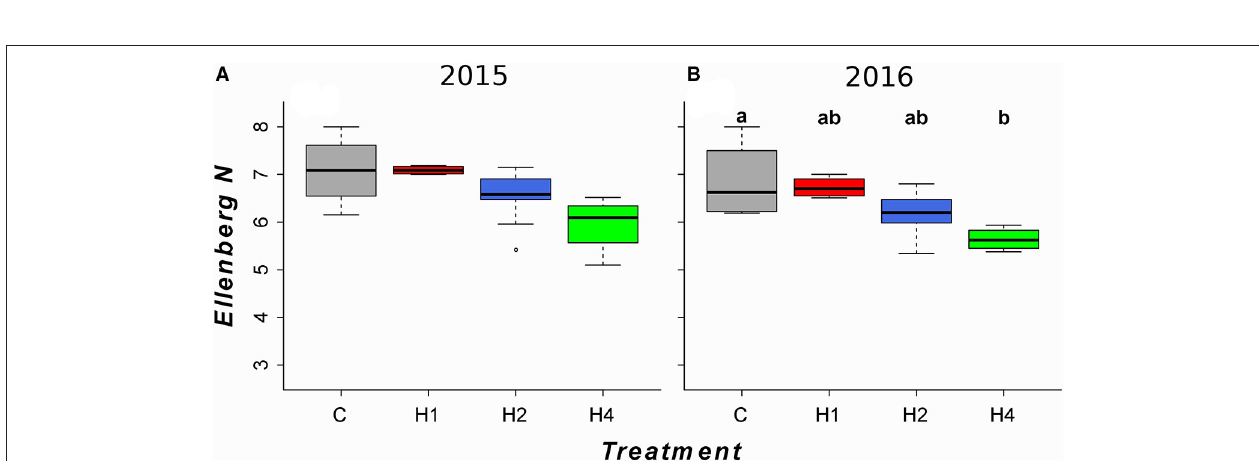
FIGURE 5 | Boxplots of community-weighted preference for soil fertility (Ellenberg N) for the second and third experimental year for the tall herb fringe community. Horizontal lines indicate the median, boxes the interquartile range and whiskers the 95% interval of the data. Panel and treatment designation as in Figure 1 . Different letters indicate significant difference ( p < 0.05) tested by linear mixed effects model with post-hoc test for pairwise comparisons (for details, see Appendix Table 4 in Supplementary Material). Community-weighted medians (min, max) after the first experimental year (non-significant, LMEM, see Appendix Table 5 in Supplementary Material) as well as boxplots for the other tested community types (non-significant, LMEM) can be found in Appendix Image 5 (Supplementary Material). (A) 2015, (B) 2016.